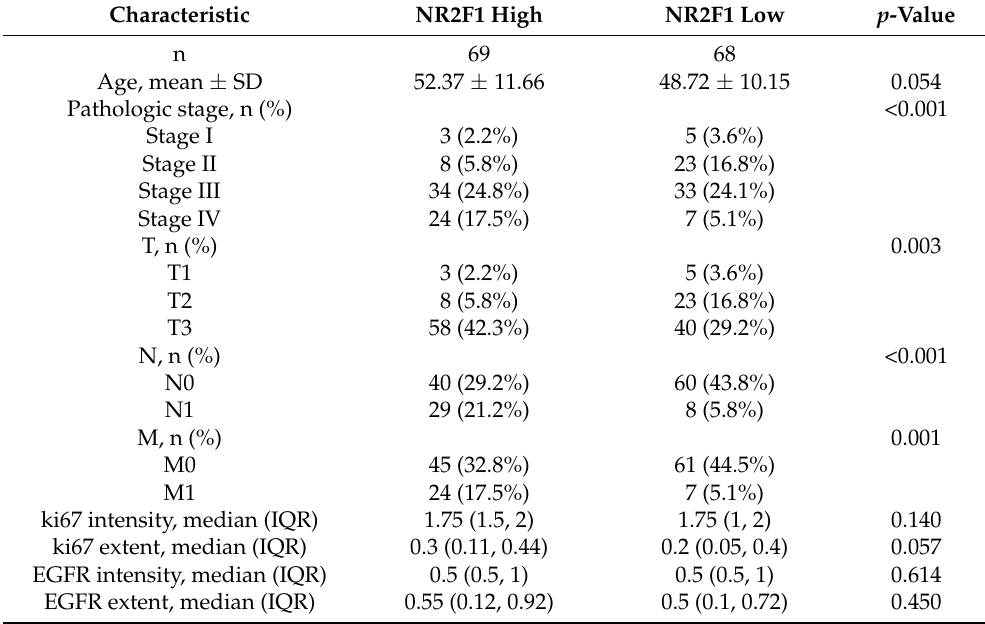
Table 2. Association between expression of NR2F1 and clinicopathologic characteristics in OC tissues. Characteristic NR2F1 High NR2F1 Low p -Value